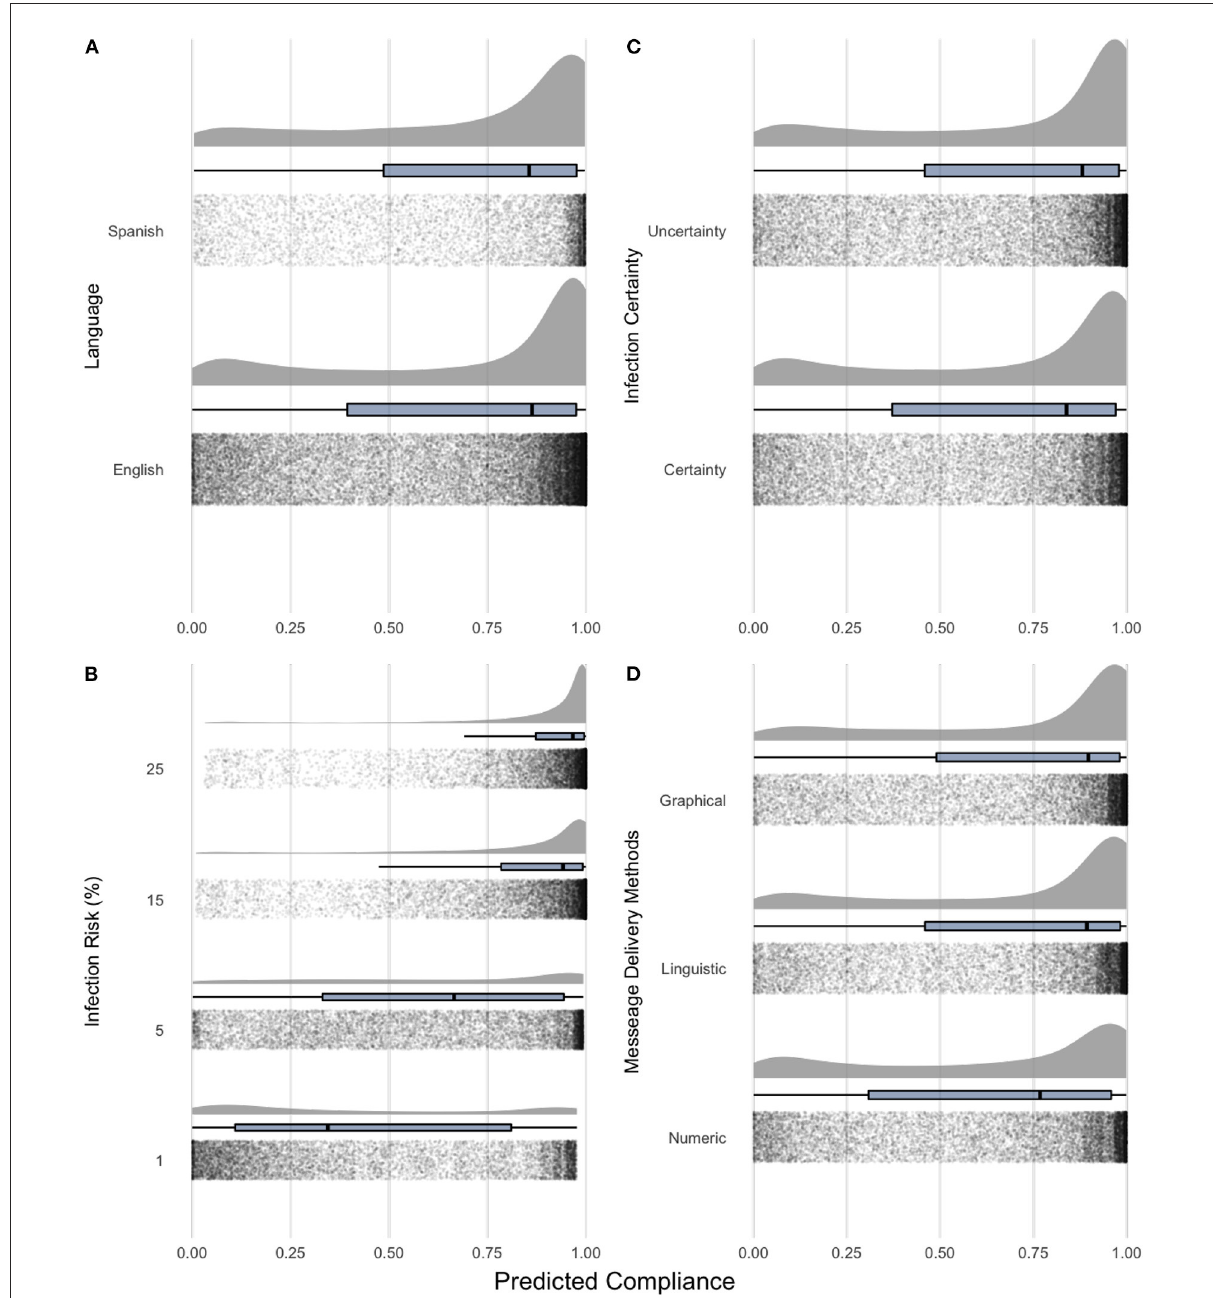
FIGURE5 Probability of using the “shower-in and shower-out” practice by the main effects, (A) participant groups; (B) , infection risk; (C) infection certainty; (D) message delivery methods. The density and box plots (25th, 50th, and 75th percentiles) are overlaid with model-predicted data